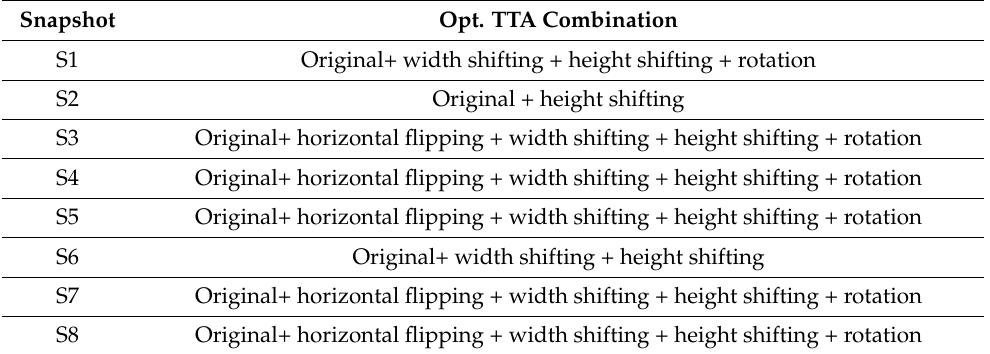
Table 5. Optimal test-time augmentation combination for each model snapshot.